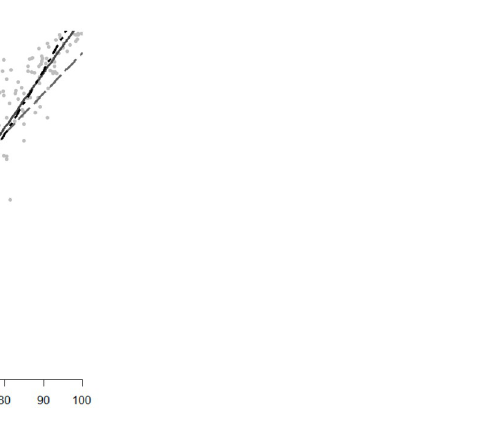
Fig 6. Relationship between the mean confidence judgments per question and the probability of recall modelled with linear and polynomial regression. Each dot represents one question. Confidence judgments were only analyzed for given responses. Regression models are hierarchical.